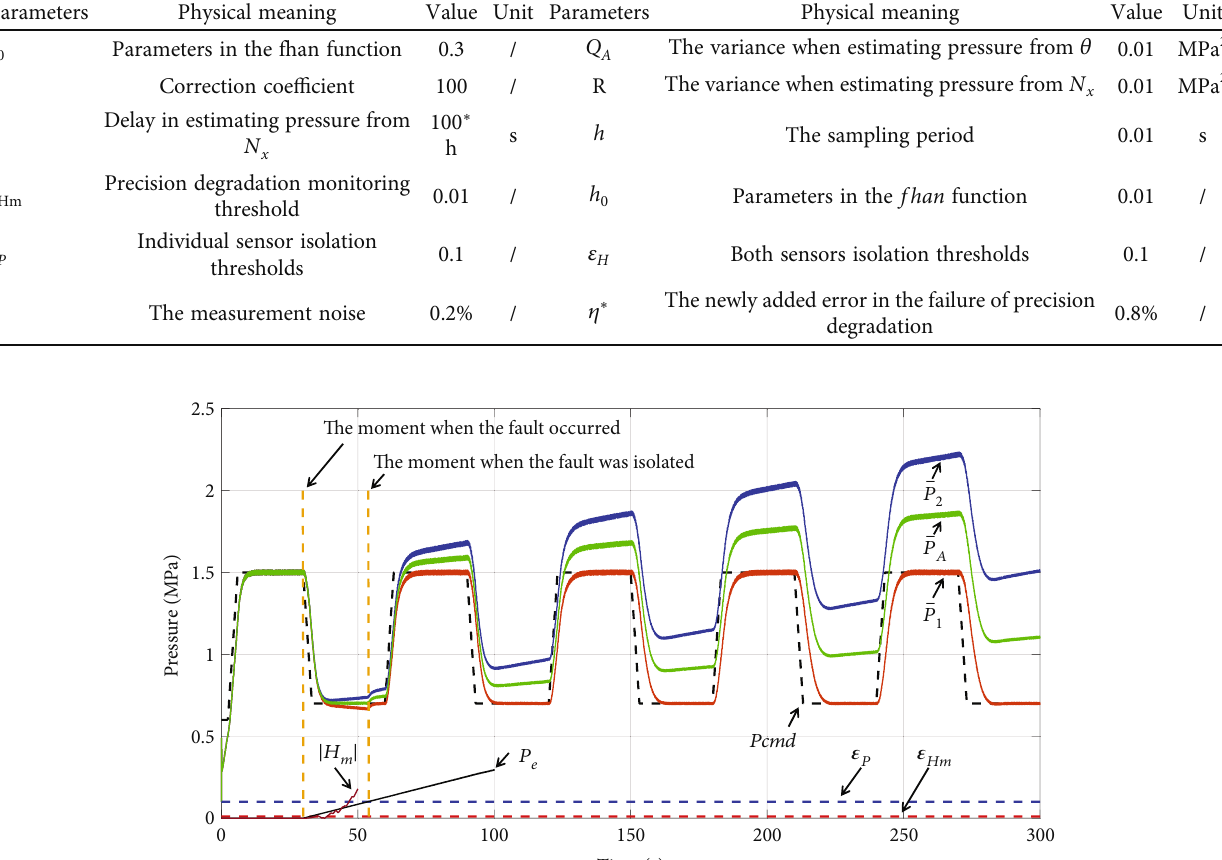
Table 2: Simulation conditions.